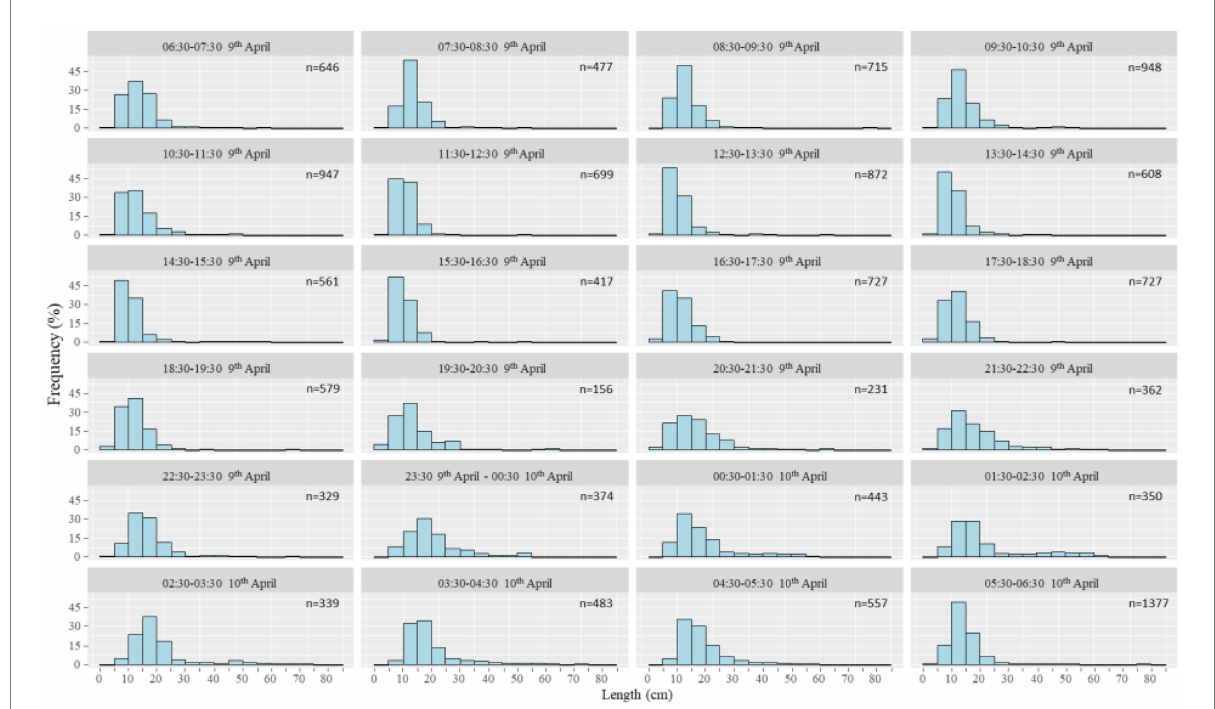
FIGURE 7 The temporal distribution of fish number and body length in a full day. The distribution of body length of spawning fish was depicted by hour in a whole day.